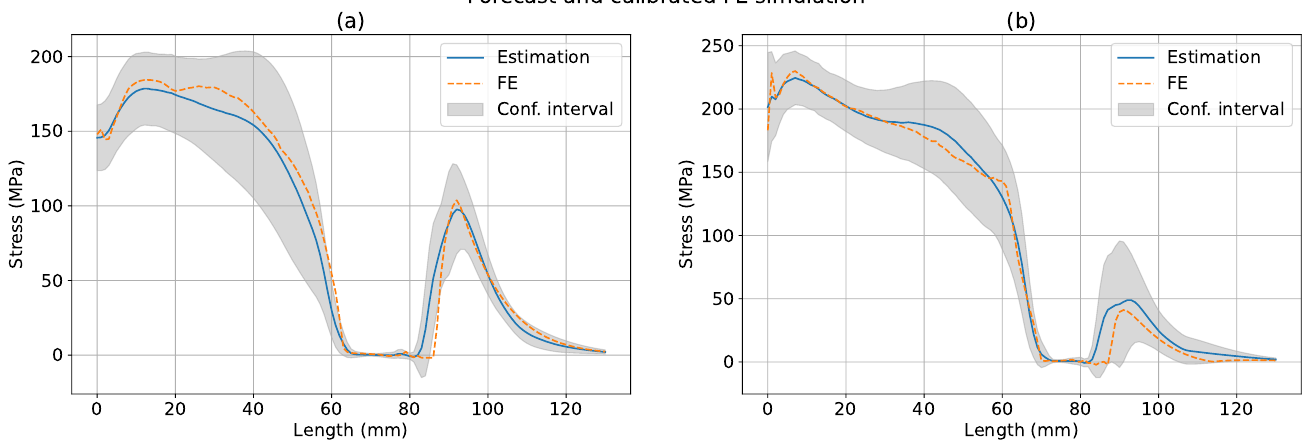
Figure 17. Forecasted maximum principal stress, FE simulation and confidence interval. ( a ) Camera side. ( b ) Torch